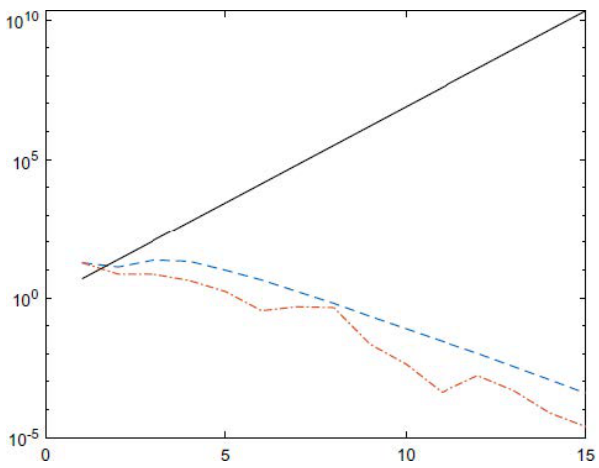
Fig. 5 FOC curve of function sint. FOC, fractional